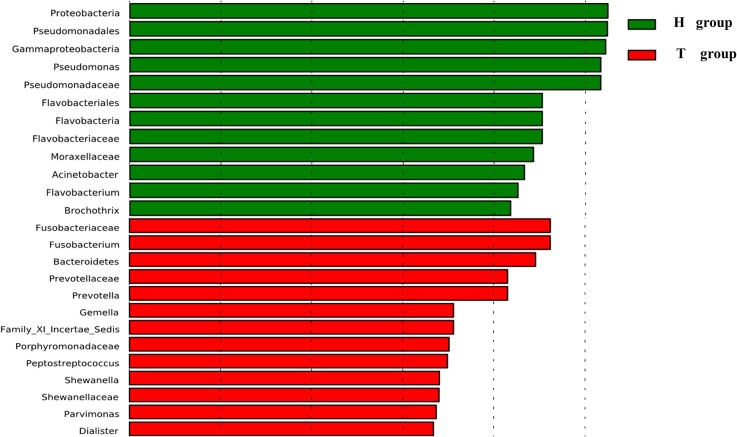
Histogram of the LDA scores for differentially abundant genera. Cladogram was calculated by LEfSe, a metagenome analysis approach.